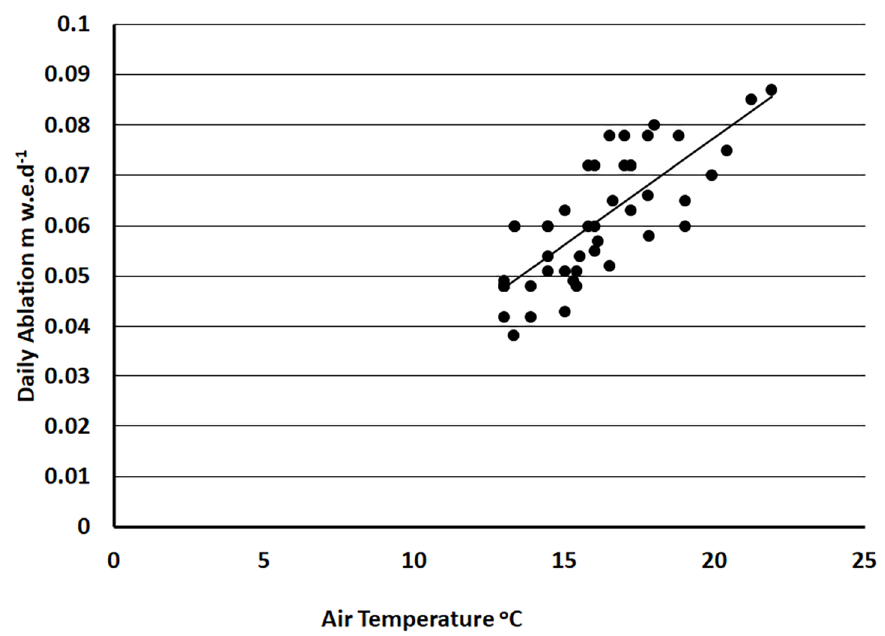
Figure 2. Daily mean air temperature at the Middle Fork Nooksack SNOTEL site and daily snow ablation measured on Sholes Glacier. The DDFs are derived from the linear regression slope coeffi- cients. Table 3. Impact of 24 heat events on North Fork Nooksack (NFN) and South Fork Nooksack dis- charge and temperature, glacier ablation, glacier runoff, and overall glacier contribution to flow of NFN.